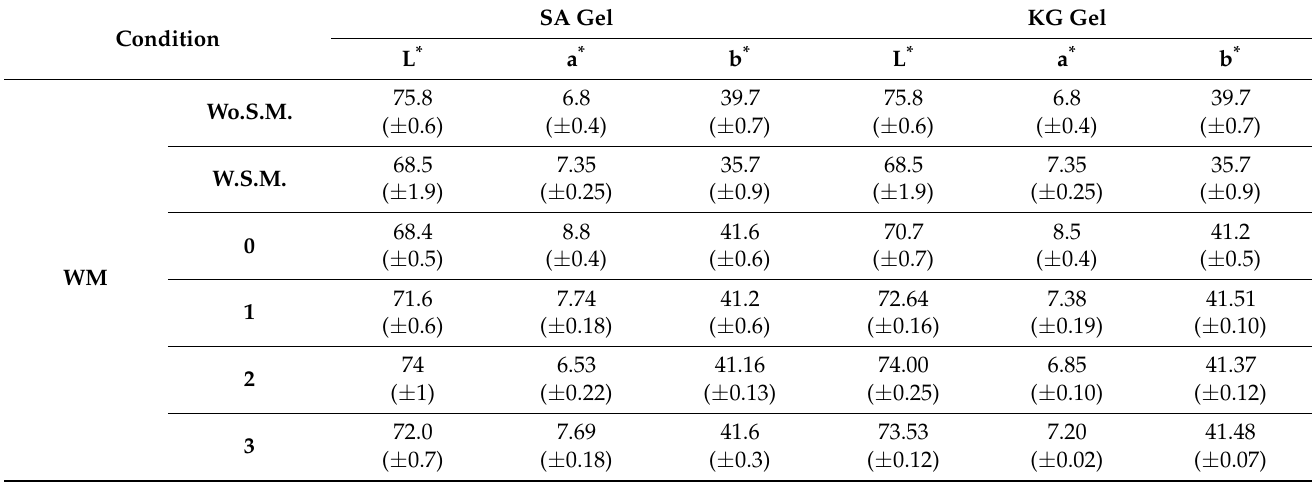
Table 2. Color coordinates L * , a * , and b * measured on WM and EAM mock-ups, without and with soiling mixture, and after cleaning with SA and KG gel by repeating applications. The average values and the related standard deviations were achieved by repeating the measurement five times. Standard deviation values are given in brackets. Wo.S.M. = without soiling mixture, W.S.M. = with soiling